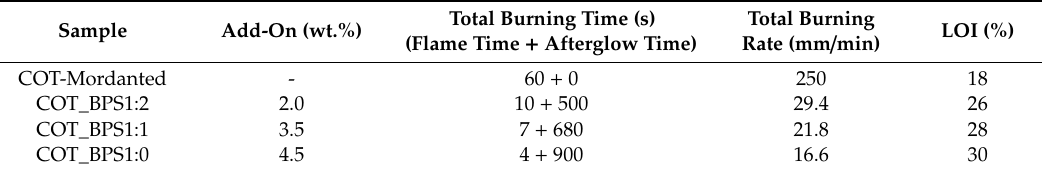
Table 22. Vertical flame spread data for cotton fabrics before and after treatment with di ff erent solutions of banana pseudostem sap.